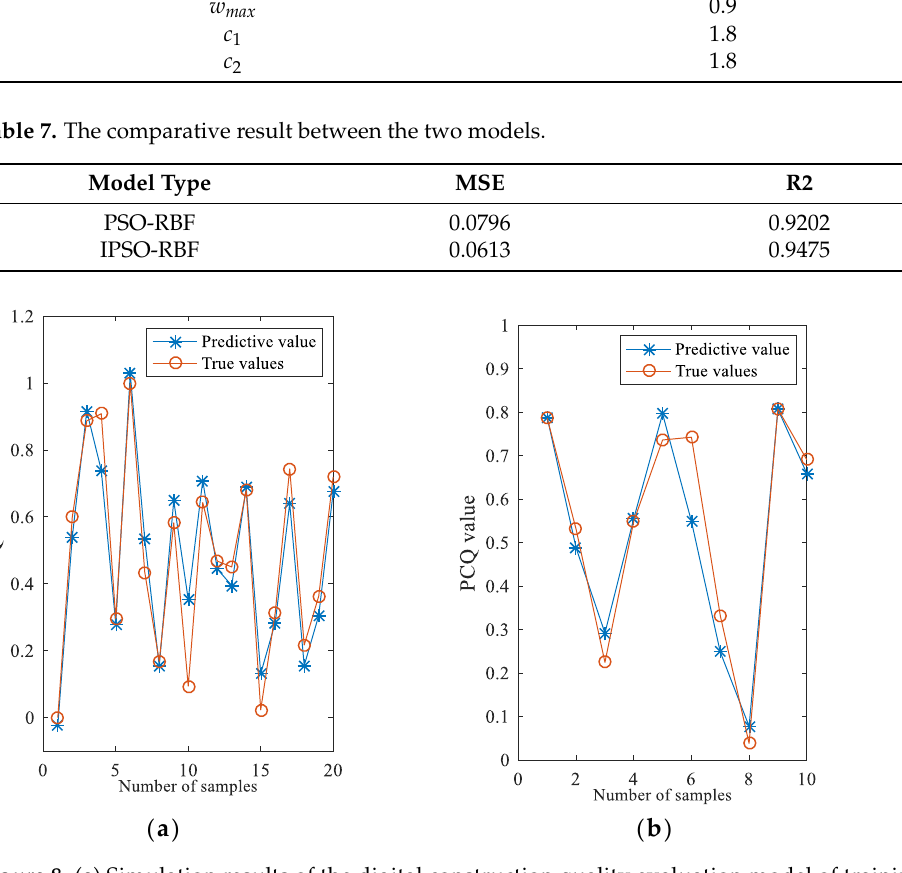
Figure 8. ( a ) Simulation results of the digital construction quality evaluation model of training set. ( b ) Simulation results of the digital construction quality evaluation model of test set.